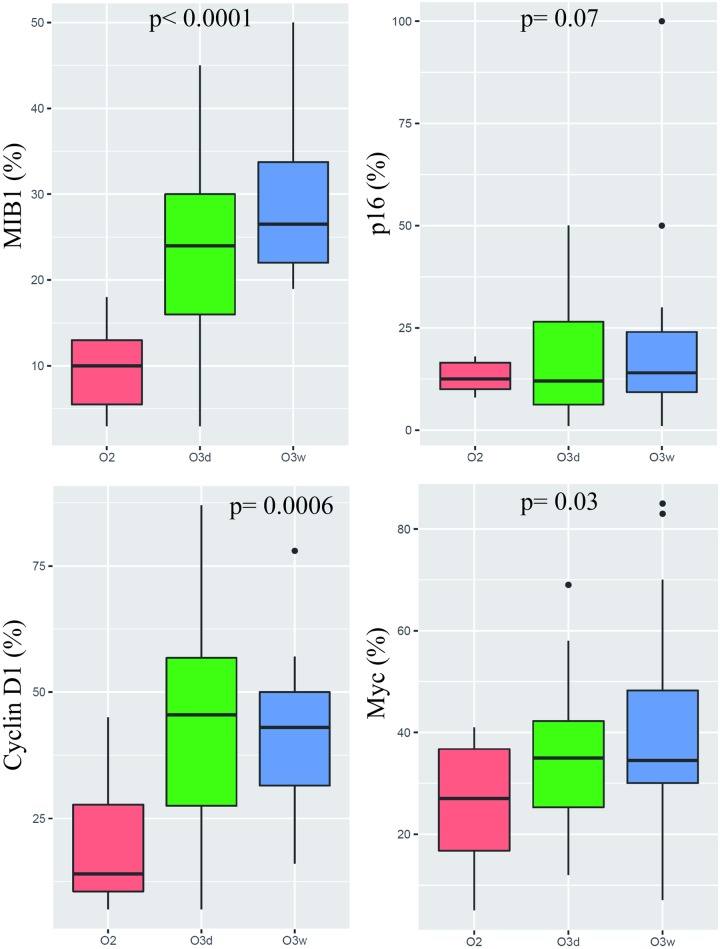
Boxplots of nuclear percentage of expression for MIB1, p16, Cyclin D1, and Myc according to the histological type.O2: Low grade oligodendroglioma. O3d: 9p deleted anaplastic oligodendroglioma. O3w: 9p wild type anaplastic oligodendroglioma.